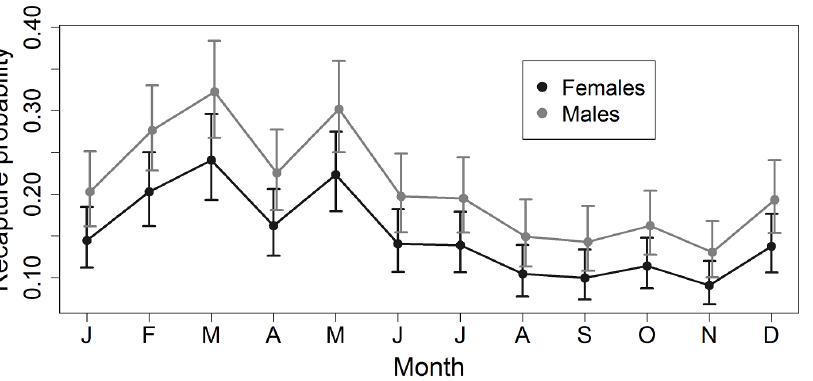
Figure 1. Monthly recapture probability of northern raccoons ( Procyonlotor ) at the Ordway-Swisher Biological Station, Florida. Estimates and 95% confidence intervals are from model { Q (sex) p (month + sex) l